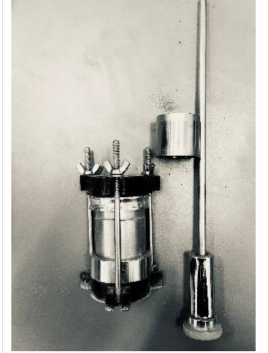
Figure 2. Compaction instrument.